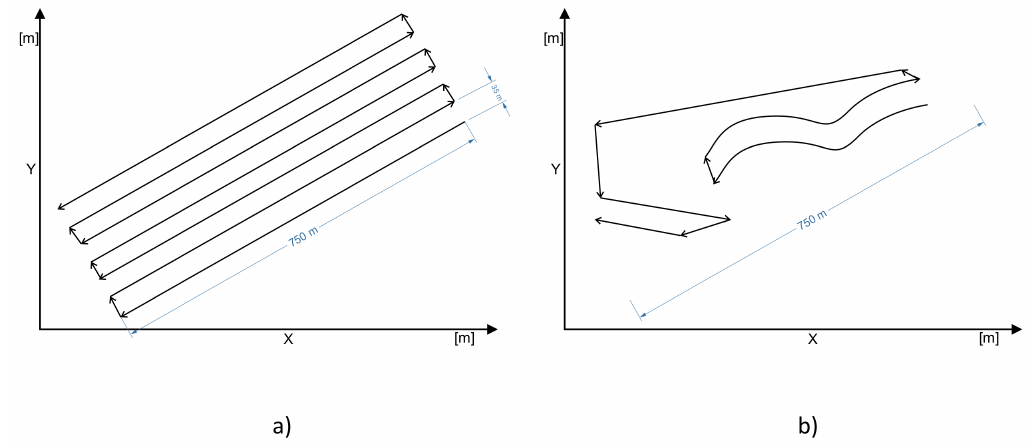
Figure 3. Flight plans: ( a ) single grid; ( b ) free